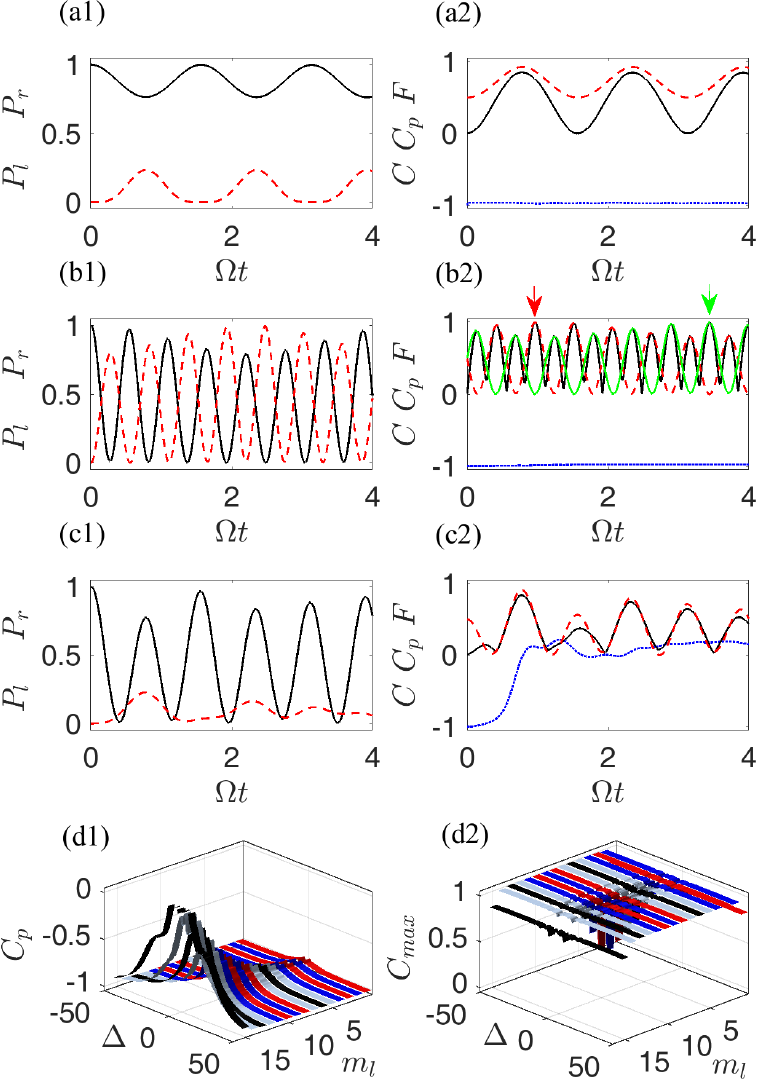
Figure 4. Calculated dynamics for an initial state of | R l (cid:105)| G r (cid:105) . ( Left ): time evolutions of collec- tive Rydberg excitation probabilities P l (solid black curve) and P r (dashed red curve); ( right ): of the concurrence C (solid black curve), the Pearson correlation coefficient C p (dotted blue curve), and the fidelities ( F − ( t ) is a dashed red curve in ( a2 , c2 ), while f + ( t ) and f − ( t ) are dashed red and dotted green curves in ( b2 ), respectively) under three sets of parameters ( a1 , a2 ): ( m l , m r , ∆ ) = (1,15,0); ( b1 , b2 ): ( m l , m r , ∆ ) = (8,8,20 MHz); ( c1 , c2 ): ( m l , m r , ∆ ) = (15,1,2 MHz). Here, ( | R (cid:105)| G r (cid:105) − | G (cid:105)| R r (cid:105) ) , while f ± ( t ) = |(cid:104) ψ ( t ) | φ ± (cid:105)| 2 with F − ( t ) = |(cid:104) ψ ( t ) | ψ − (cid:105)| 2 with | ψ − (cid:105) = 1 √ l l 2 | φ ± (cid:105) = 1 √ ( | R (cid:105)| G r (cid:105) − e ± i π /2 | G (cid:105)| R r (cid:105) ) . Pearson correlation coefficient C p ( d1 ) and the maximal con- l l 2 currence C max ( d2 ) as a function of the single-photon detuning ∆ and the number of atoms m l in the left subsuperatom for the evolution time Ω t = 4. The total atom number m = 16 remains unchanged. Other parameters are given at the beginning of Section